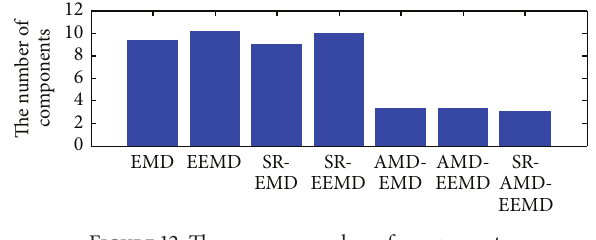
Figure 12: The average number of components.